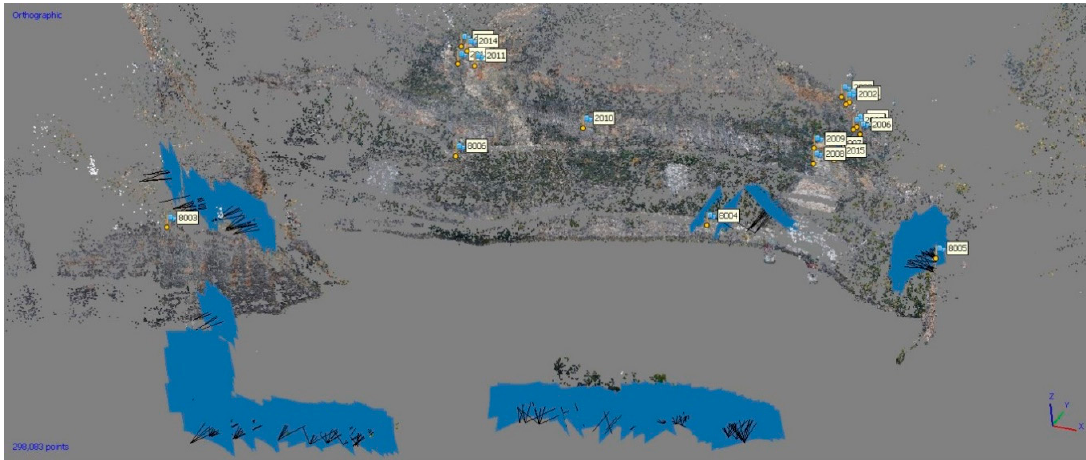
Figure 5. Set of imagery used for the bundle adjustment of the normal and tele cameras and visualization of the measured points on geodetic pillars and check points.